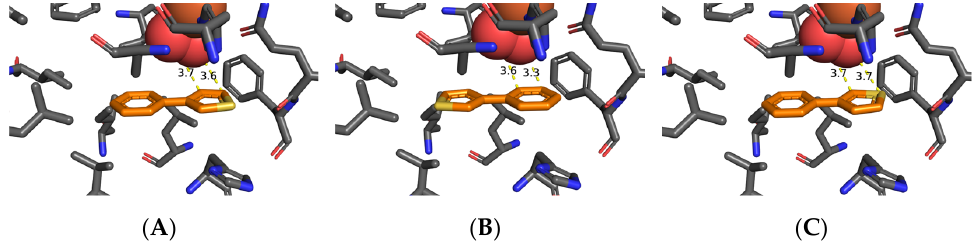
Figure 3. Preferred orientation of 3-phenylthiophene 1k for TDO-catalyzed: thienyl cis -dihydroxylation ( A ), phenyl cis -dihydroxylation ( B ), and sulfoxidation ( C ).